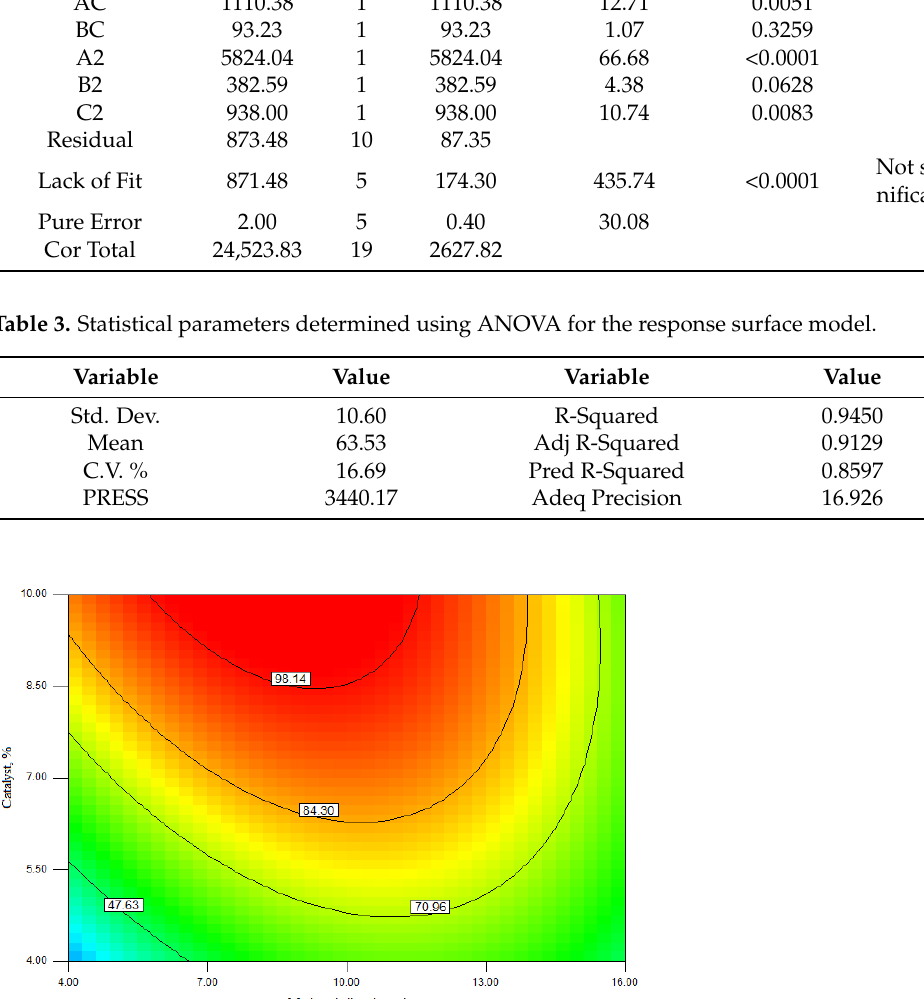
Figure 1. Response surface contour plot for the interaction between the catalyst amount and the methanol-to-oil molar ratio for the ester yield (the process duration is 7 h).